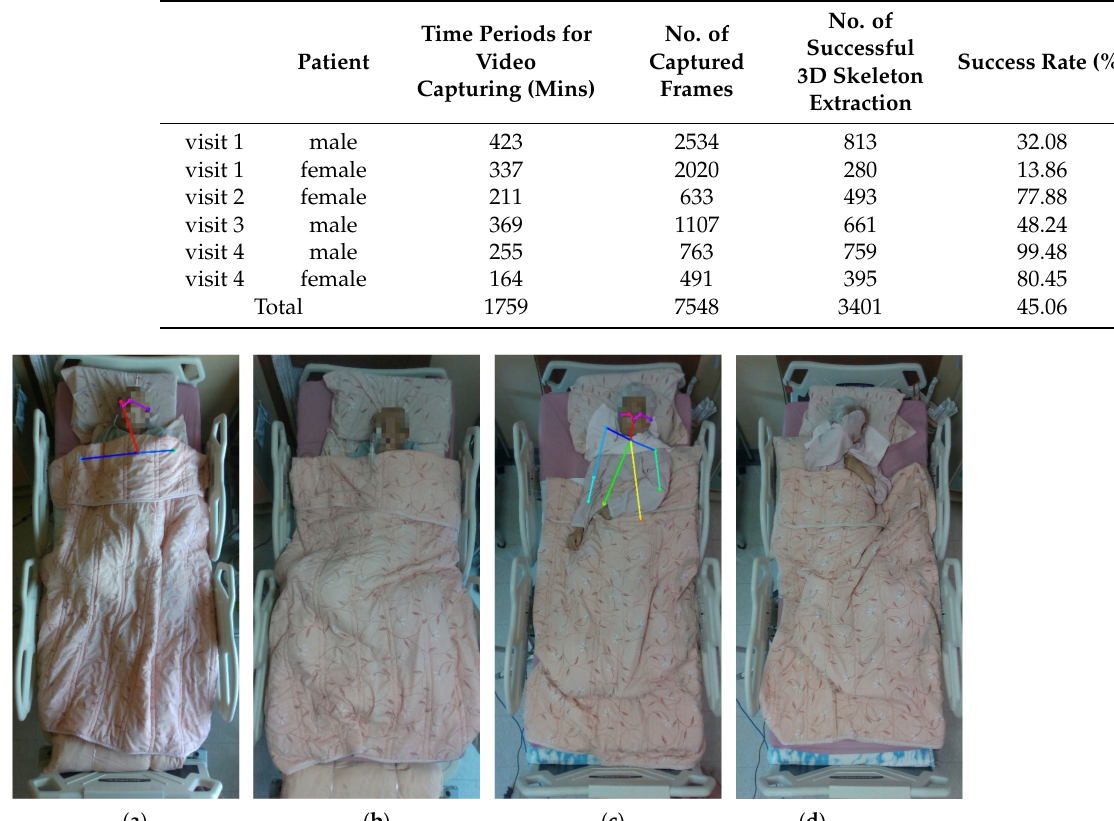
Figure 5. Some failed cases in clinics: incorrect skeleton in ( a , c ); no skeleton in ( b , d ).